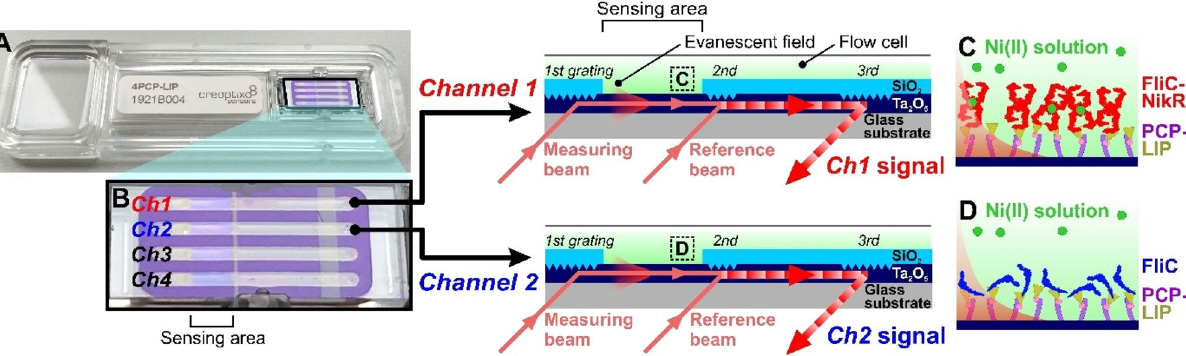
Figure 1. Structure of the applied 4-channel WAVEchip. ( A ) Full image of a PCP-LIP WAVEchip with its fluidic channels enlarged in ( B ) Two channels, a measurement and reference channel ( Ch1 and Ch2 ) are further detailed. The interference signal (phase-shift) is produced by the combination of the measuring beam and phase modulated reference beam inside the Ta 2 O 5 waveguide film. The two beams are coupled through two optical gratings and the combined beam is coupled out by a 3rd grating. All the gratings and the path of combined beam are covered by a thin SiO 2 layer (light blue) in order to avoid sensing of any refractive index change outside the indicated sensing area. The evanescent field generated by the electromagnetic mode propagating in the waveguide film (dark blue) is also indicated. Both channels have the same structure and are coated with